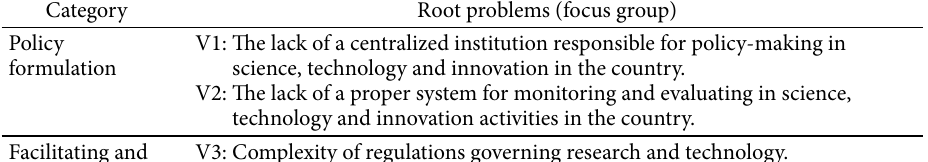
Category Root problems (focus group) Policy